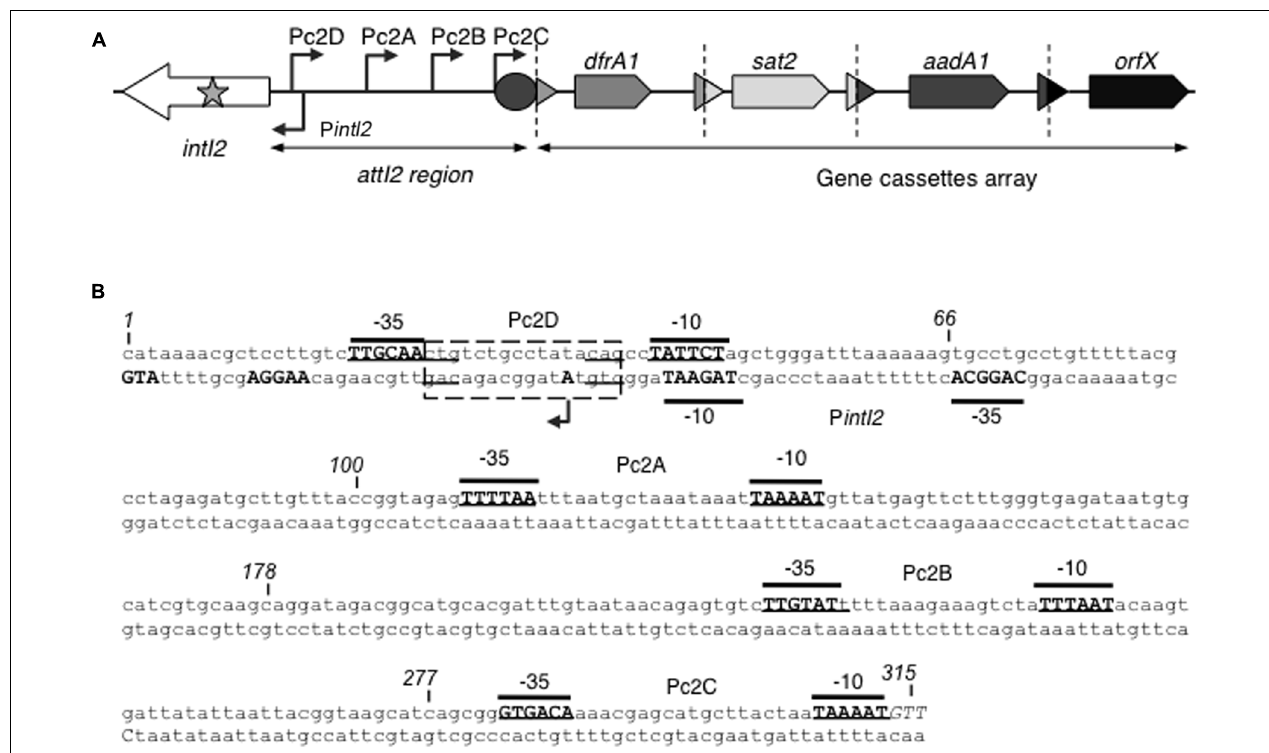
FIGURE 1 | Class 2 integrons. (A) General structure of class 2 integrons: Arrows indicate the coding sequences with the gene name above, triangles and circles are attC and attI recombination sites, respectively. The attI2 region and gene cassette array are indicated . Dotted vertical bars separate each gene cassette. The putative promoters are shown as broken arrows with their names indicated. orfX is a pseudocassette whose attC site is incomplete. The star symbolizes the nonsense mutation that disrupts most intI2 genes. (B) Nucleotide sequence of the attI2 region. The − 35 and − 10 elements of the putative promoters are written in bold uppercase, and their names are indicated. The intI2 START codon and its putative RBS are written in bold uppercase on the bottom strand. The transcriptional ( + 1) mapped for P intI2 is indicated by a broken arrow and bold uppercase. The putative LexA box is represented as a dotted rectangle. The position of several nucleotides is numbered